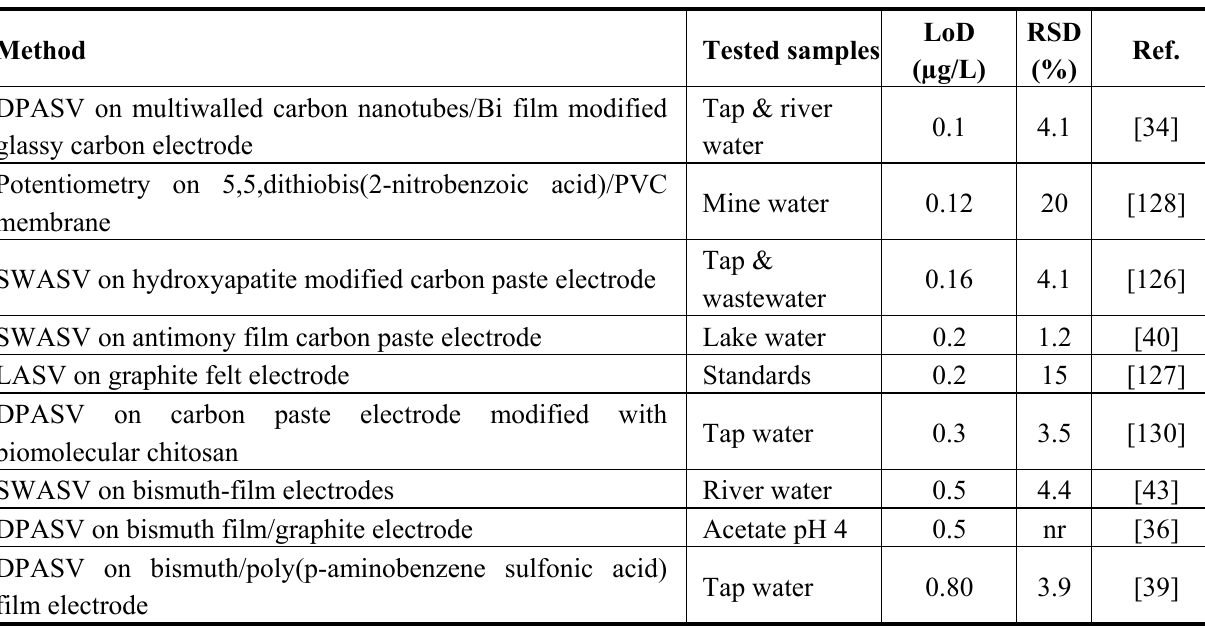
Table 8. Analytical characteristics of electrochemical sensors for lead determination in water, published between 2007 and